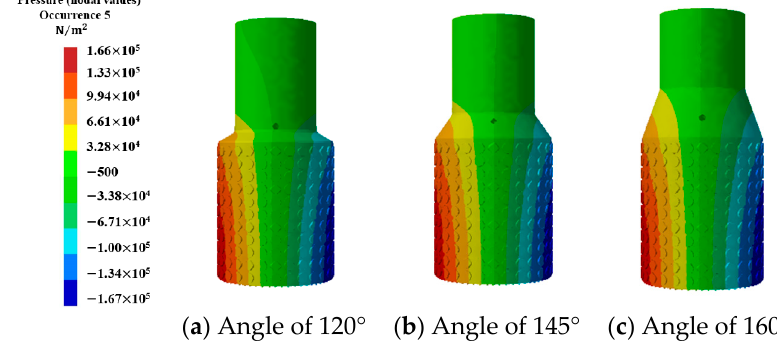
Figure 12. Fifth-order acoustic cavity modality.